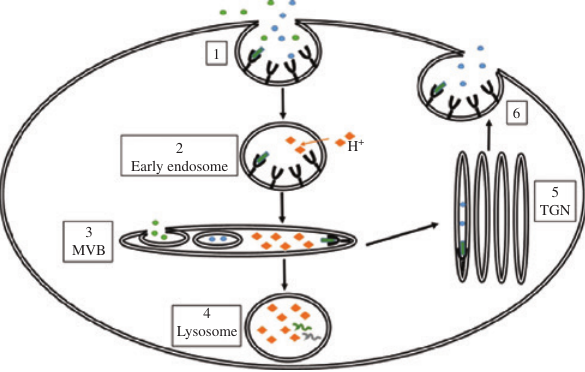
Figure 1: An overview of